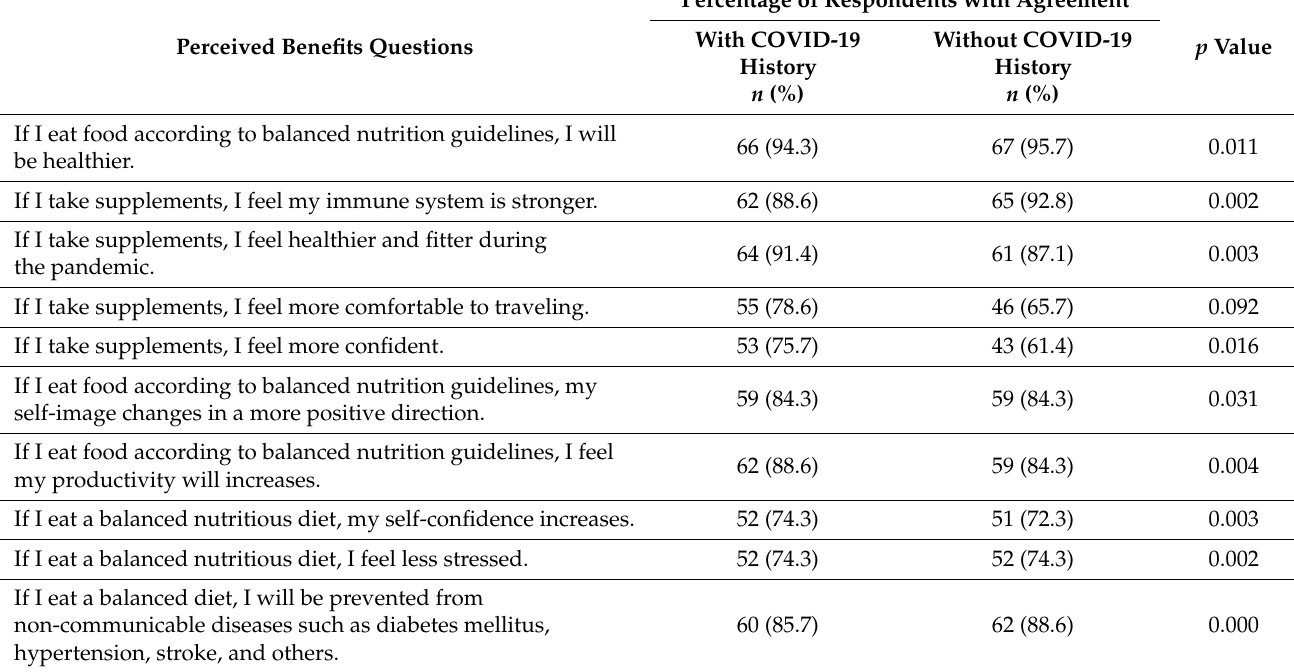
Table 4. Perceived benefit